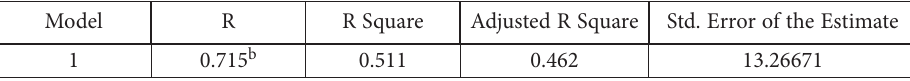
Table 8. Summary of regression